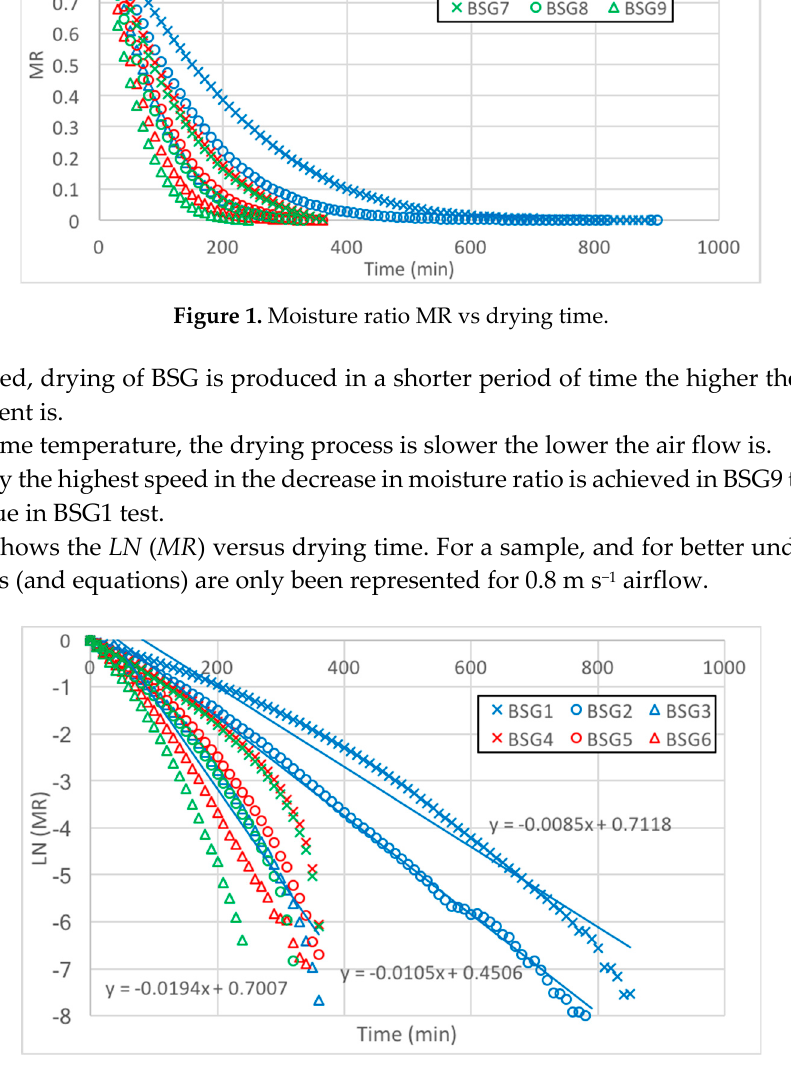
Figure 2. Moisture ratio MR vs. drying